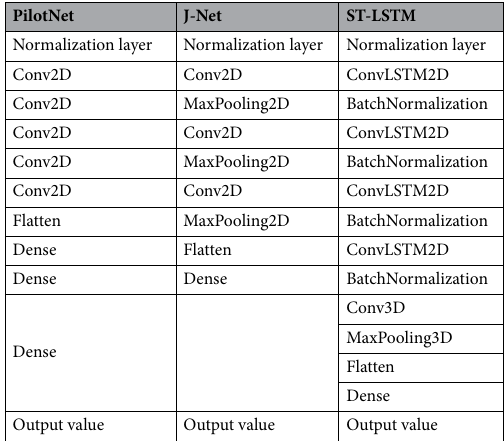
Table 1. Setting for all networks.